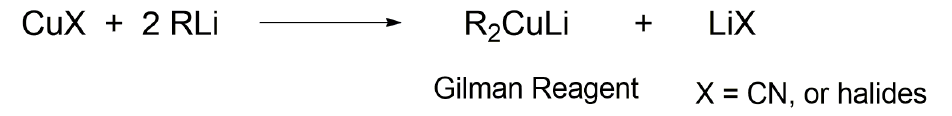
Figure 2. The First Dialkylcuprate Reagent Prepared by Gilman. Stoichiometric lithium dialkylcuprates (i.e., R 2 CuLi) were later used by House and Whitesides to effect 1,4-conjugate addition to α, β-enones [31]. This reaction was highly chemoselective (i.e., 1,4-adduct vs. 1,2-adduct), affording an excellent chemical yield (1,4- adduct vs. 1,2-adduct) and high reproducibility [31]. Thus, this reaction by House and